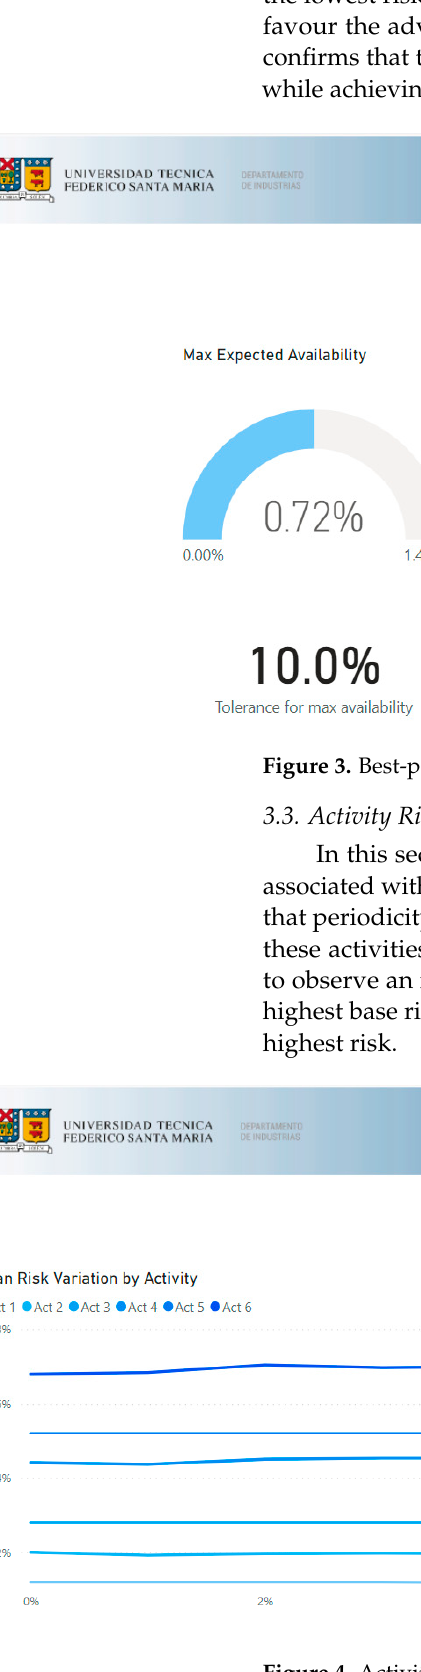
Figure 4. Activity risk assessment section.